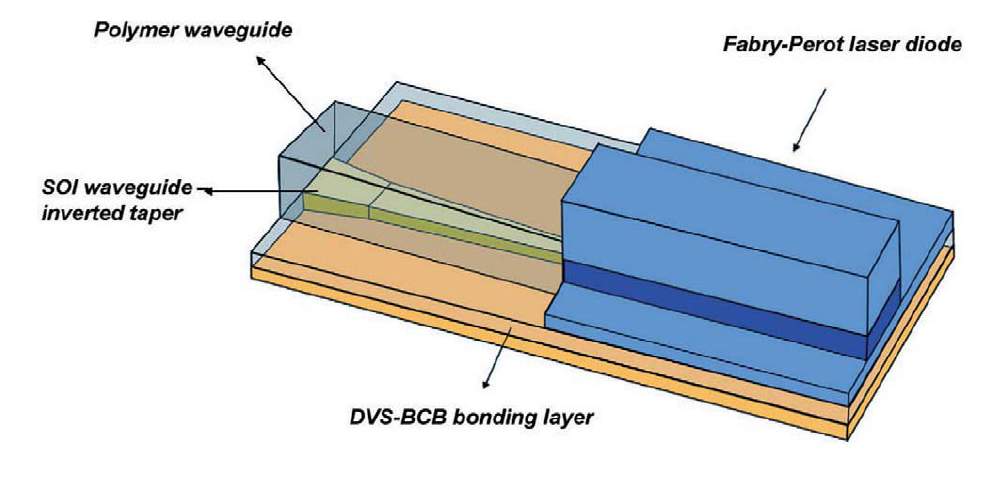
Figure 12. Schematic of the layout of the optical coupling scheme for efficient and fabrication tolerant coupling between a bonded Fabry-Perot laser diode and an underlying SOI waveguide circuit using an inverted adiabatic taper approach